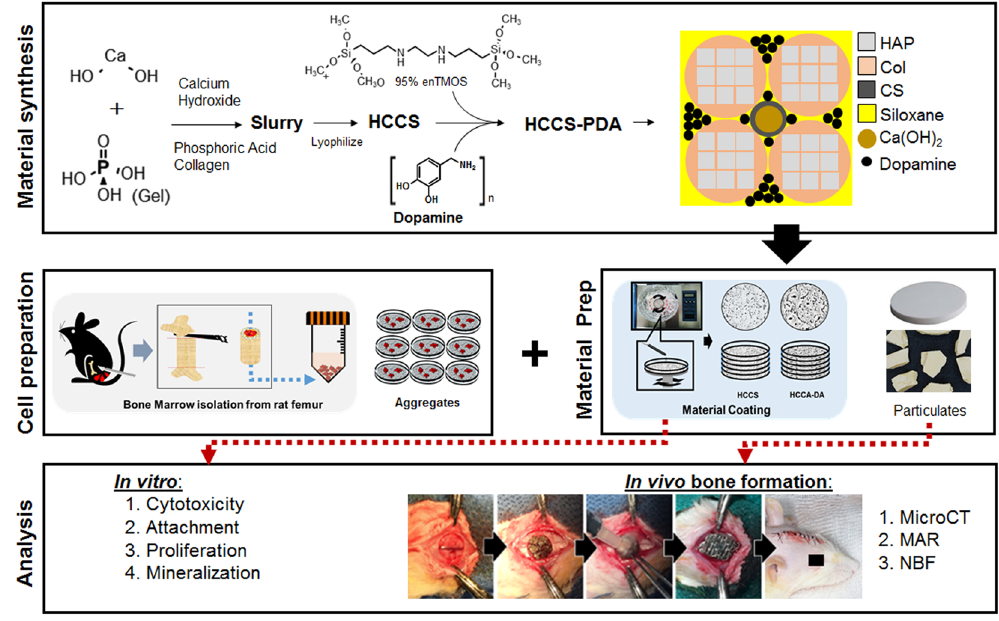
Figure 1. Schematic of the